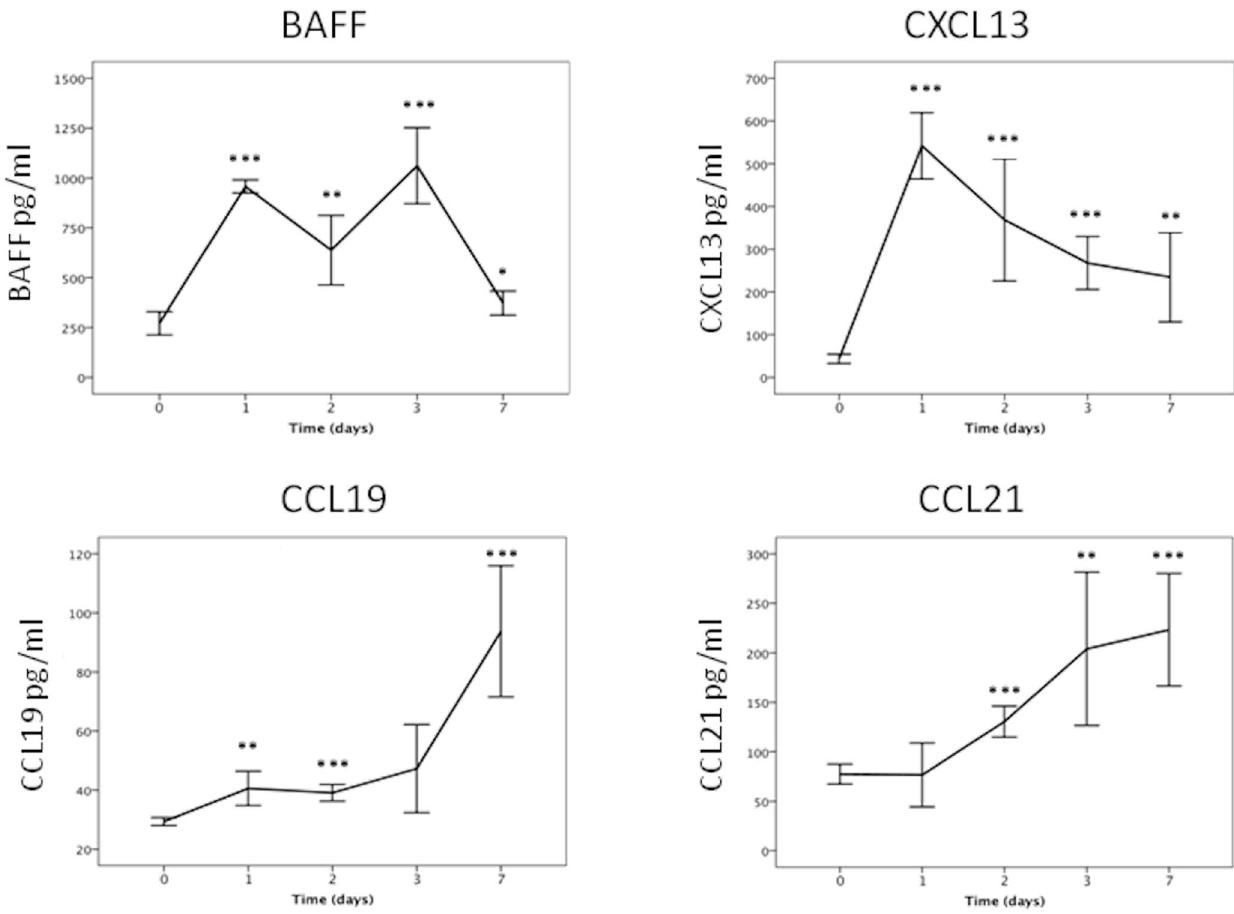
Figure 5. Expression of BAFF, CXCL13, CCL19 and CCL21 in mouse lung tissue. Each cytokine was measured at days 1, 2, 3 and 7 days after infection with 10 6 CFU of P. aeruginosa LESB65 by ELISA. [n=5]. BAFF was significantly expressed at days 1 [p , 0.001], 2 [p , 0.01], 3 [p , 0.001], and 7 [p , 0.05] in comparison to day 0 control. CXCL13 at days 1, 2, 3, [all p , 0.001] and 7 [p , 0.01]. CCL19 at days 1 [p , 0.01], 2 [p , 0.001], and 7 [p , 0.001]. CCL21 at days 2 [p , 0.001], 3 [p , 0.01] and 7 [p , 0.001]. *=p , 0.05, **=p , 0.01, ***=p , 0.001.